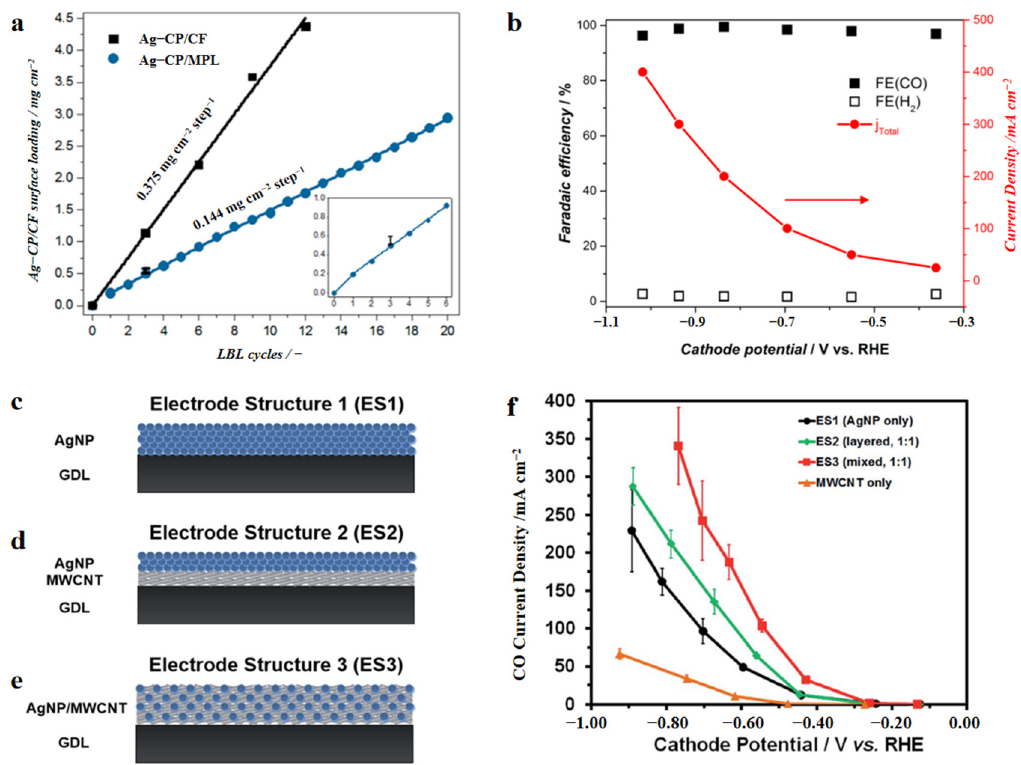
Figure 3. ( a ) Surface loading of Ag coordination polymer vs. cycles of layer-by-layer